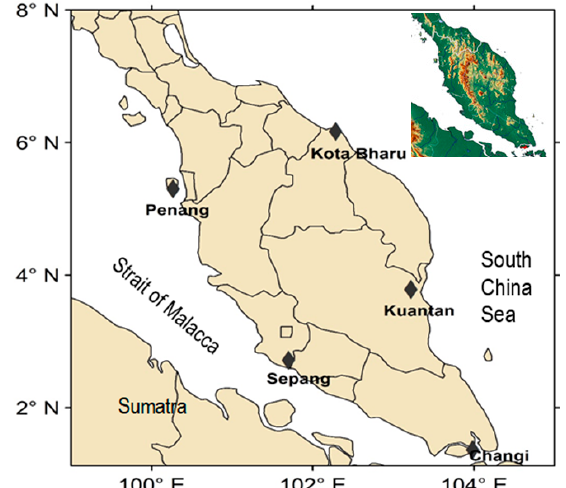
Figure 2. Peninsular Malaysia showing integrated global radiosonde archives (IGRA) stations (filled diamond), from which integrated precipitable water vapour (IWV) data were obtained. Inset is the topographic map of the study area.